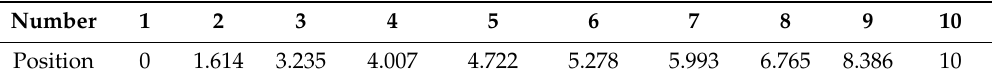
Table 3. Array element positions of the vector hydrophone array optimized by V − OG −